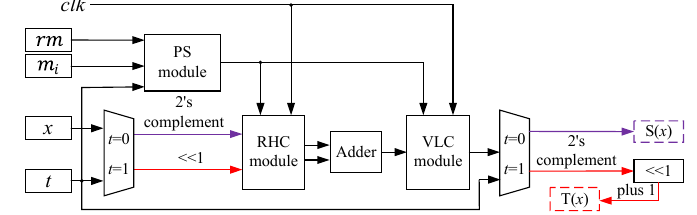
( rm , m ) ) of computing S & T . i V